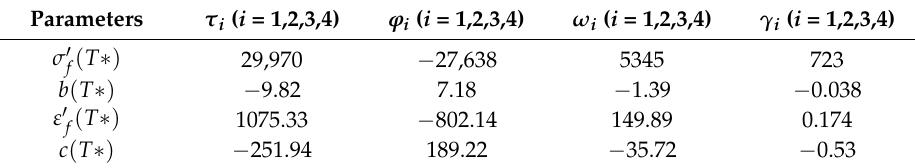
Table 4. Modified MCB model parameters identified from LCF lives at different temperatures. Parameters